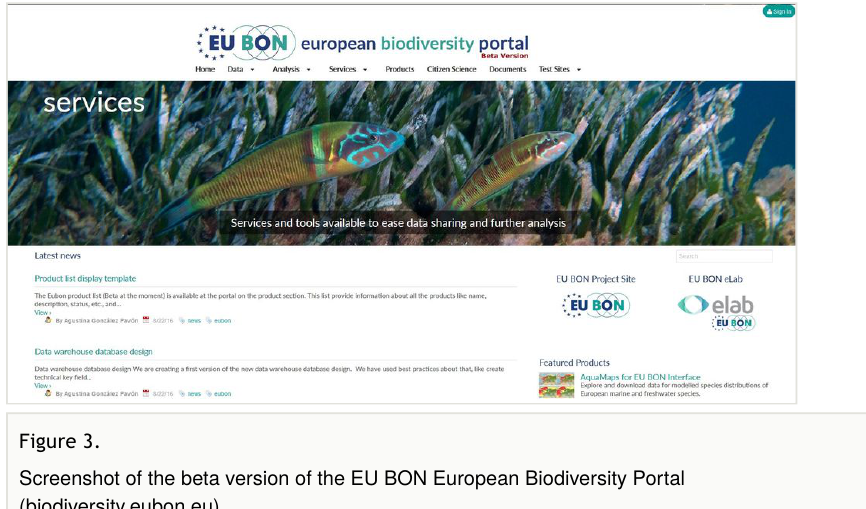
Screenshot of the beta version of the EU BON European Biodiversity Portal